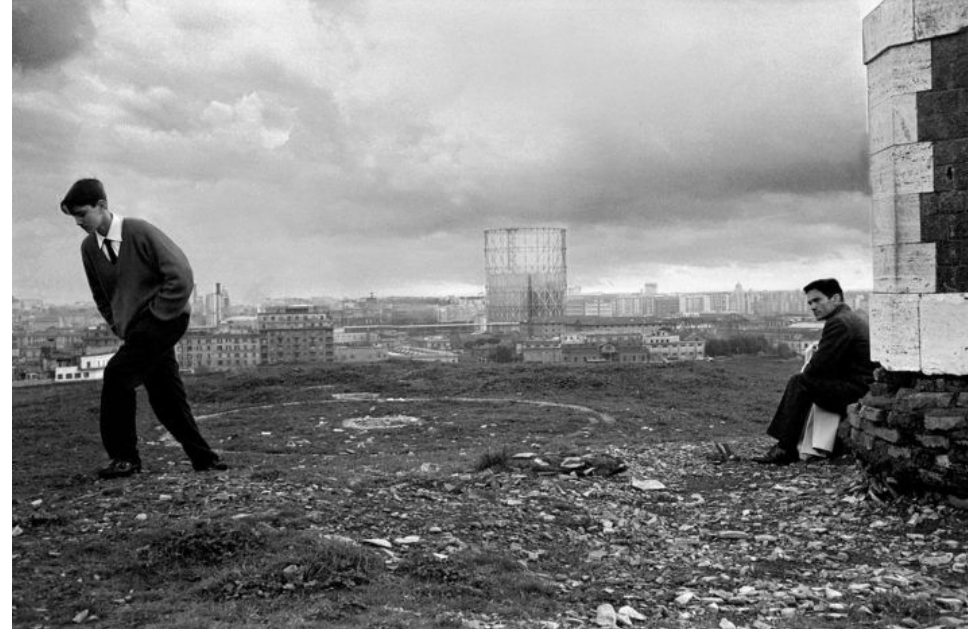
Figure 2. Pier Paolo Pasolini at “monte dei cocci”, Rome, 1960. Photograph by Paolo Di Paolo © Archivio Paolo Di Paolo. Courtesy Collezione Fotografia Museo nazionale delle arti del XII secolo (MAXXI).